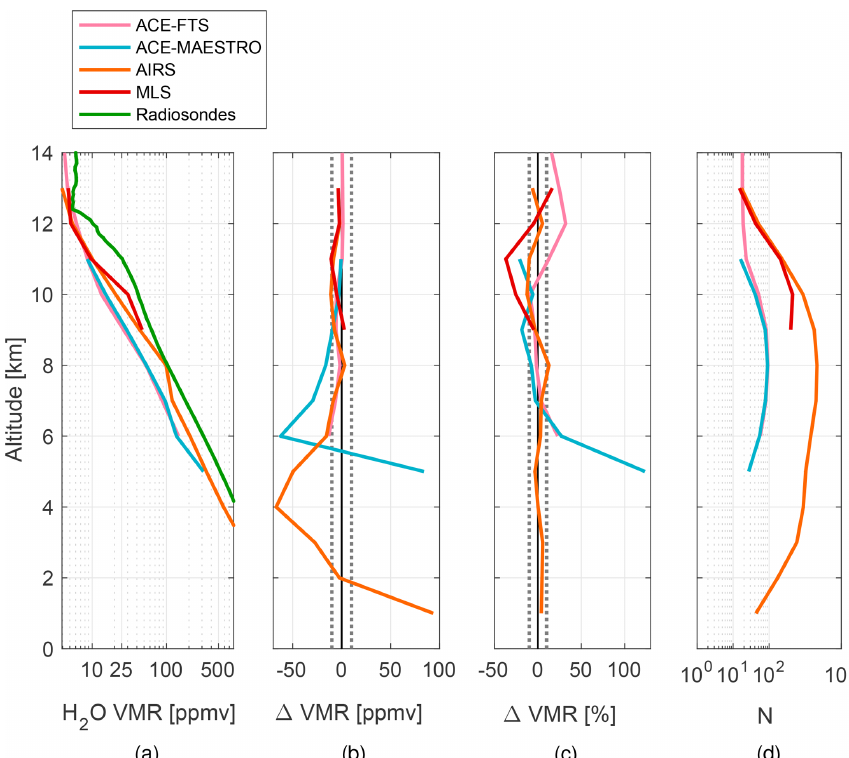
Figure 9. Same as Fig. 6, but with a summary of differences between satellite measurements and Eureka radiosondes. A version of this figure with only the ACE-FTS and ACE-MAESTRO is available in the Supplement as Fig. S2.